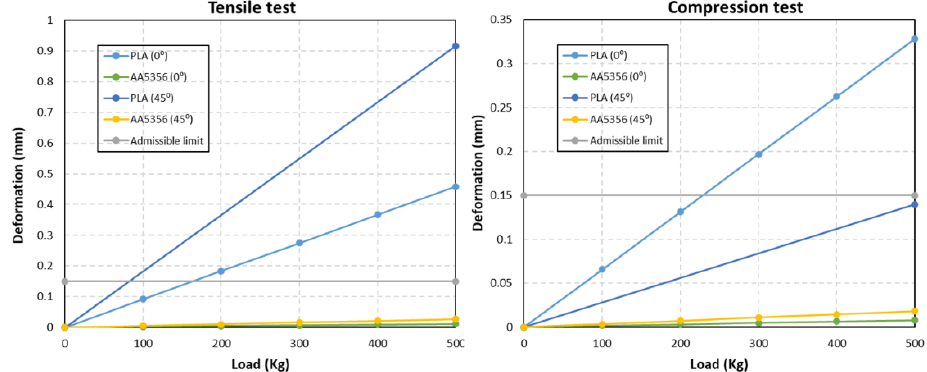
Figure 10. Deformation of the turret for WAAM AA5356 and PLA at different loading weights under the tensile and compression tests.